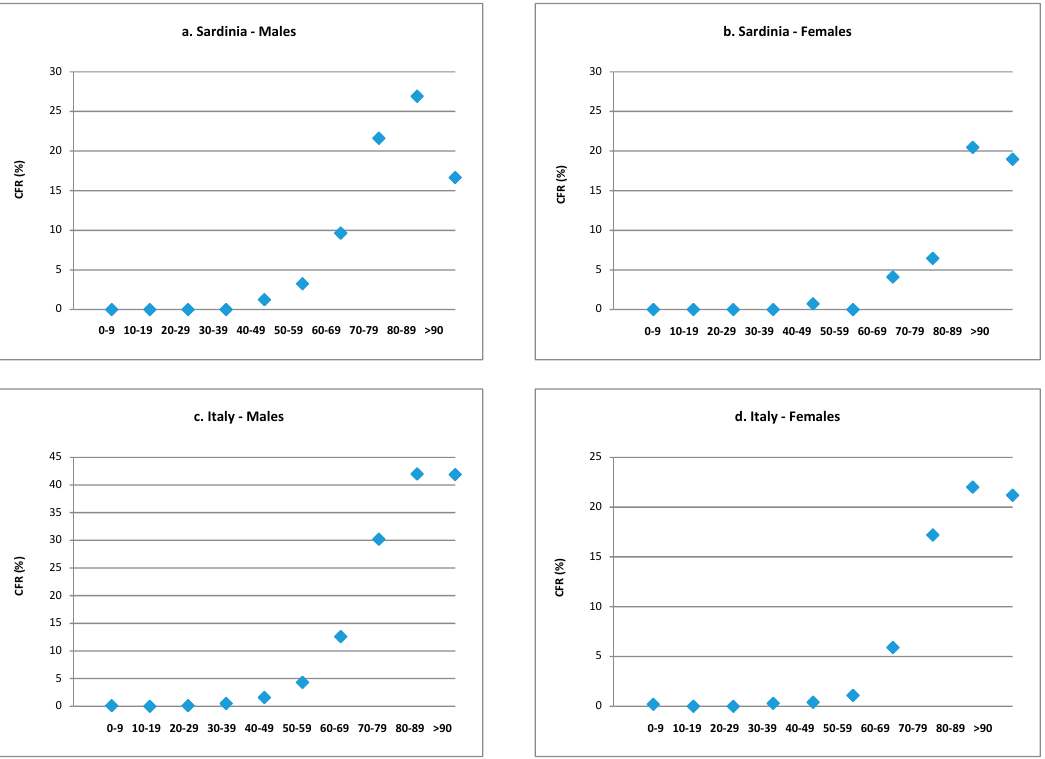
Figure 2. Trajectories of specific SARS-CoV-2 case fatality rate for Sardinian and Italian population by age groups and gender. (a) Sardinia—males. (b) Sardinia—females. (c) Italy—males. (d) Italy—females.